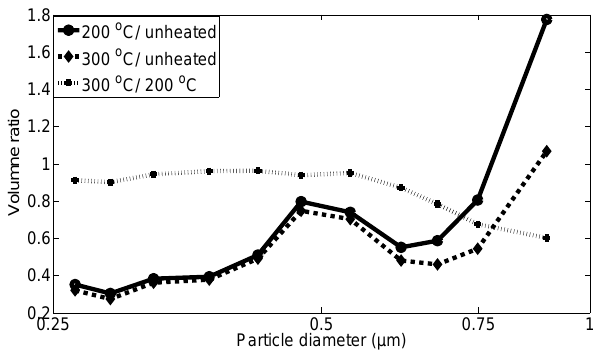
Fig. 4. Median size distributions for different OPC temperatures (a) particle number concentration (b) particle number concentration with logarithmic axes (c) particle volume concentration (d) particle volume concentration with logarithmic axes.